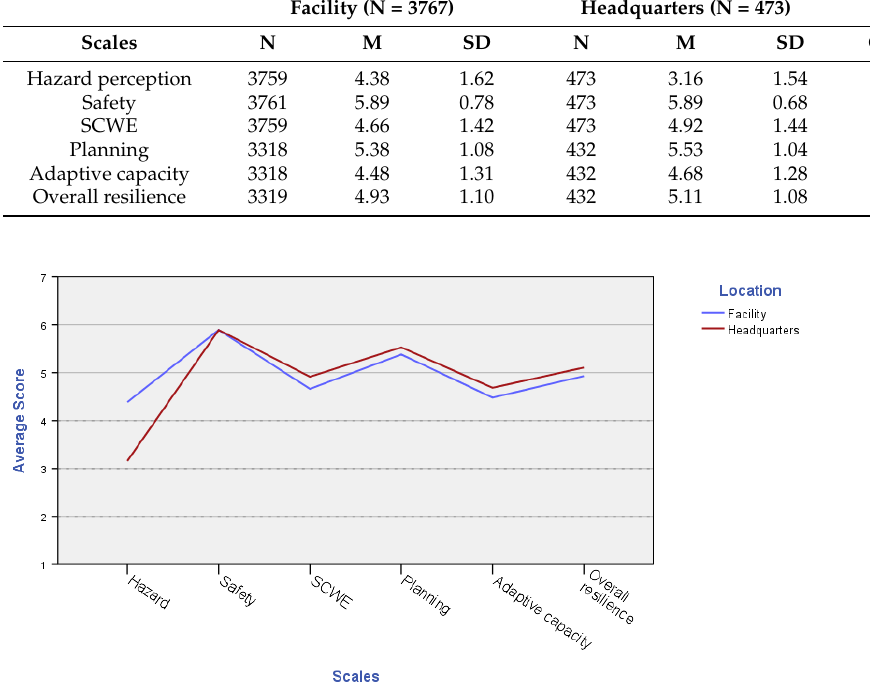
Figure 9. Scales averages by location.